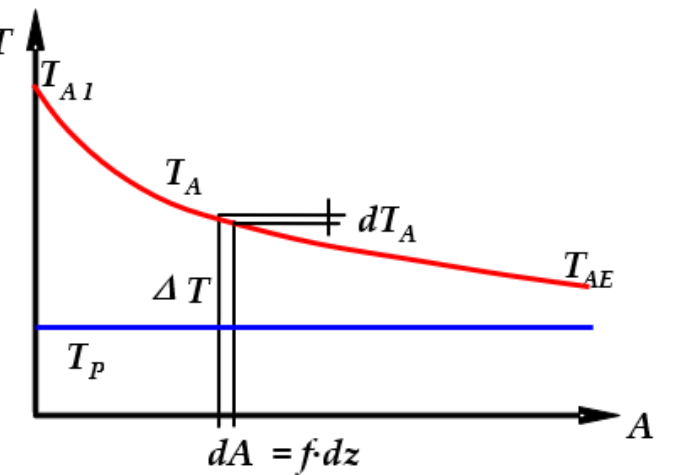
Figure 2. Diagram of the temperature of the air T A (red line) and product T P (blue line) vs. the exchange surface A . The elemental area dA is equal to the product of elemental length dz and the quantity f (see Figure 3).